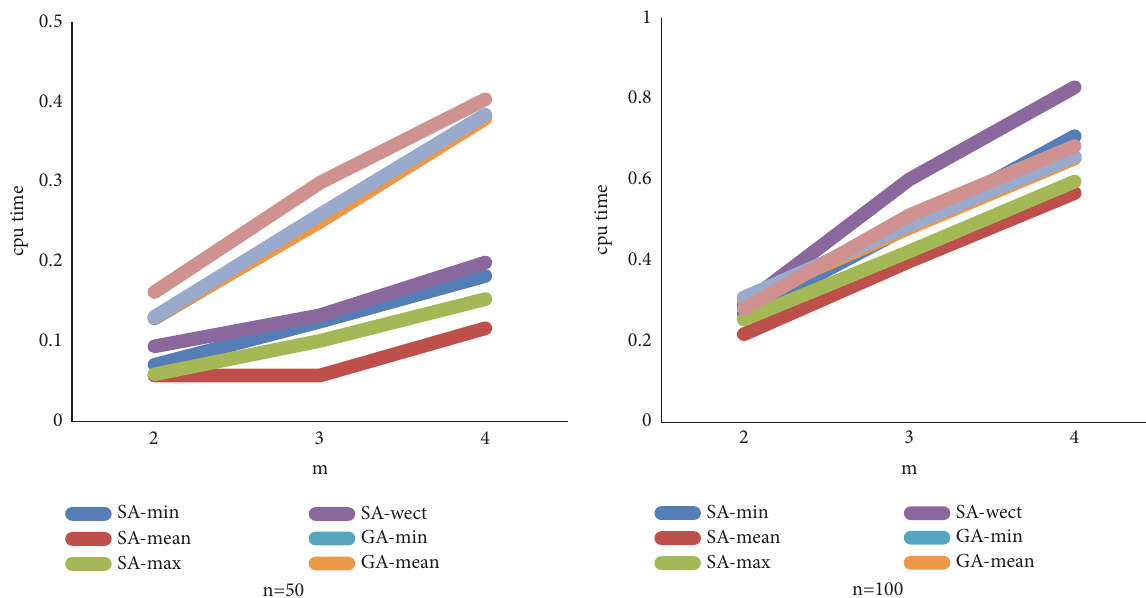
Figure 5: Change of CPU time for each 𝑛 as 𝑚 increases for SAs and GAs for large number of